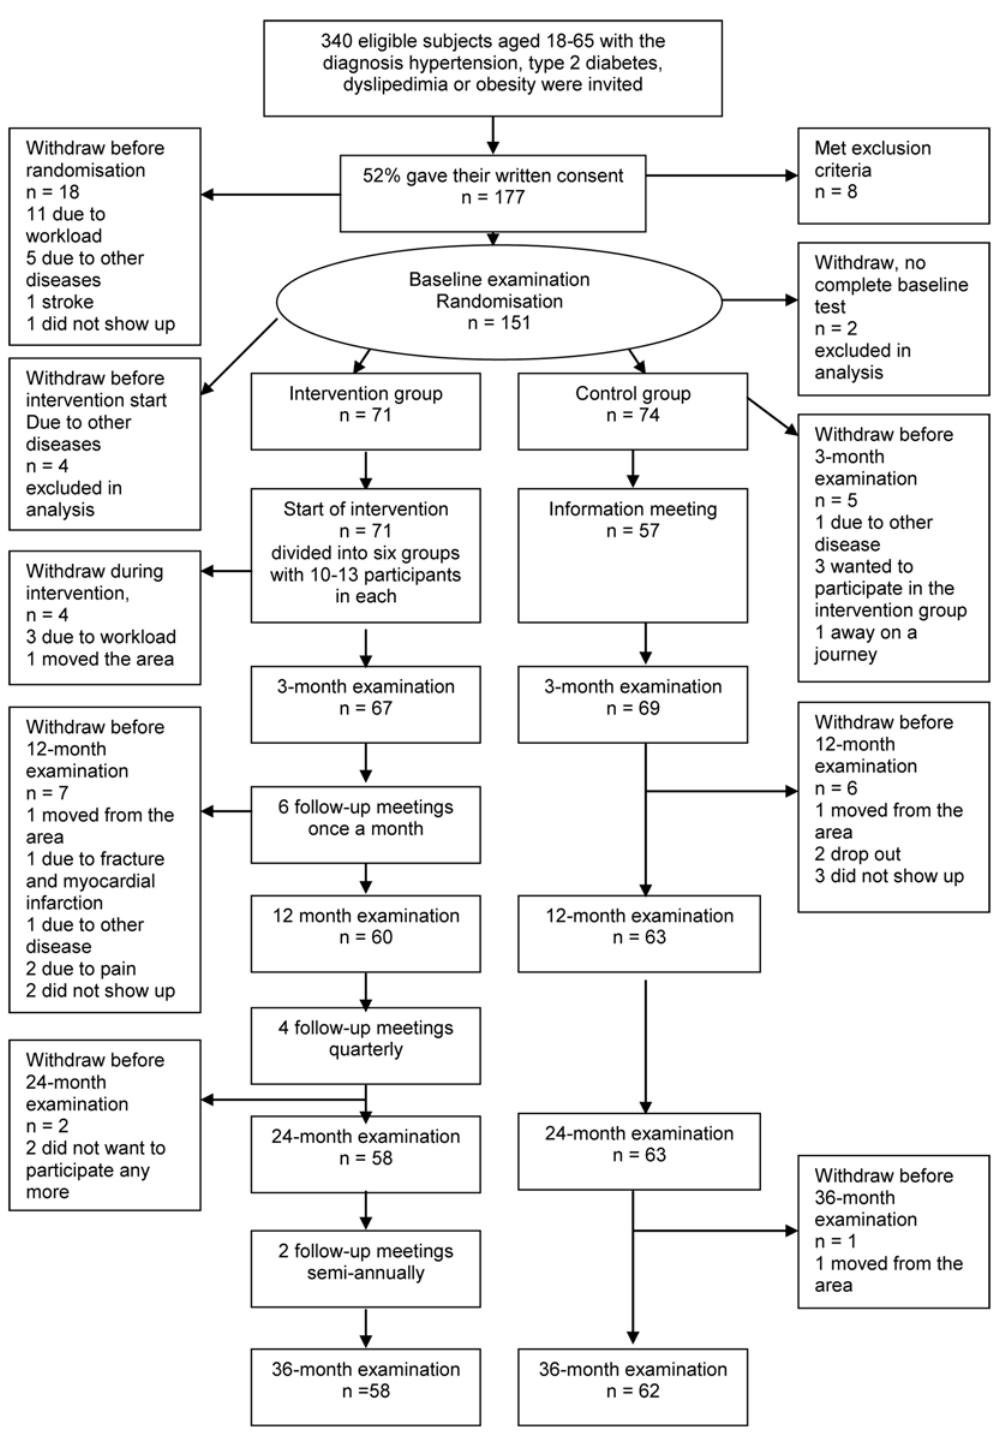
Figure 1. Participants flow Diagram.